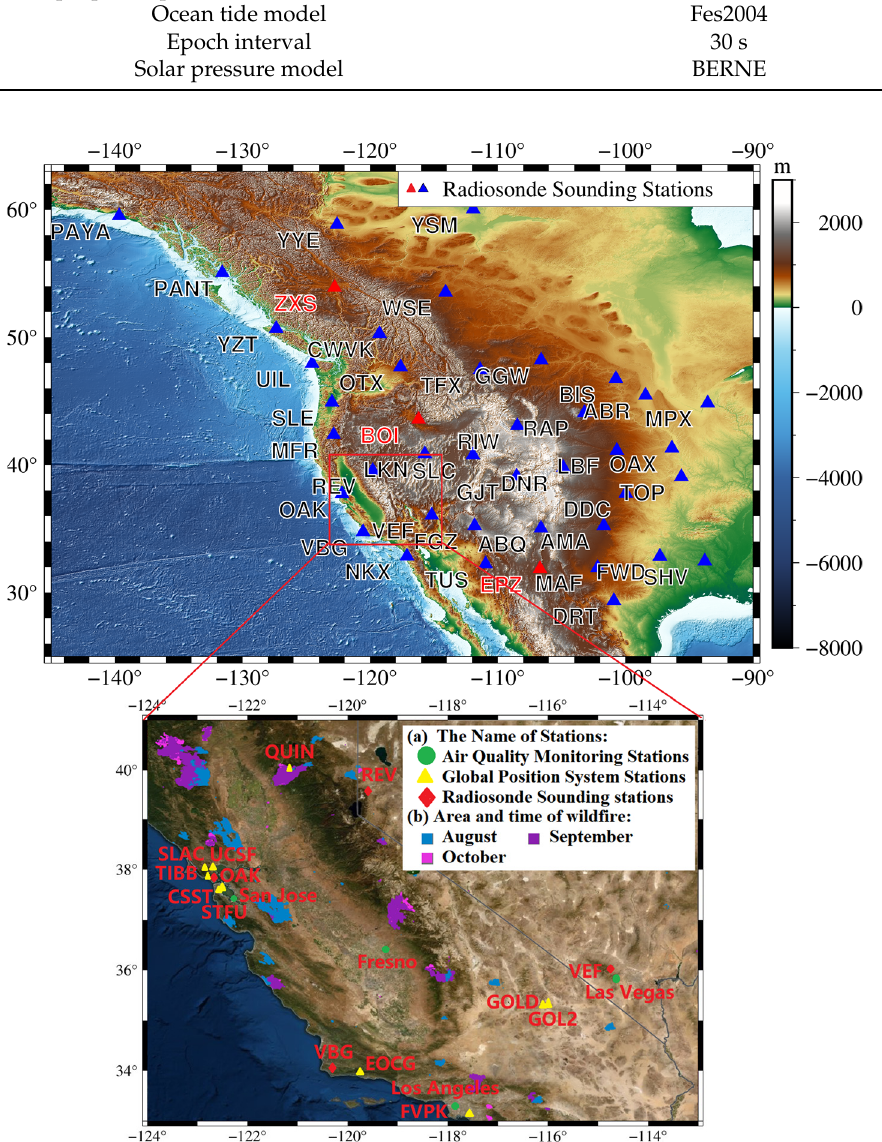
Figure 1. Global Navigation Satellite System (GNSS) stations, radiosonde sounding stations, and air quality monitoring stations. Table 2. The average accuracy of GNSS-derived zenith wet delay (ZWD) and GNSS-derived like precipitable water vapor